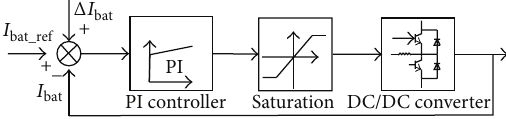
Figure 11: Battery current control loop.